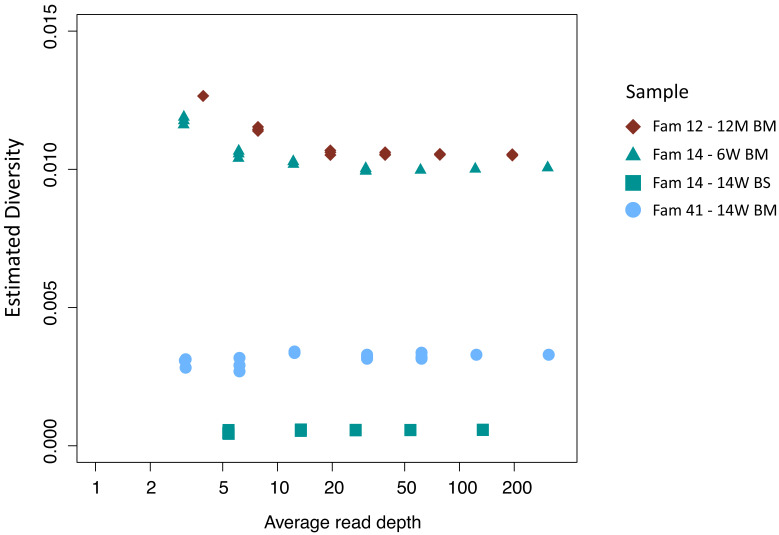
Effect of down-sampling on estimated diversity.Samples tested include family 14: 14W BS (green squares), family 41: 14W BM (blue dots), family 14: 6W BM (green triangles), family 12: 12M BM (maroon diamonds) all of which had initial read depths of 150 or more. The estimated diversity is relatively insensitive to read depth; in particular, down-sampling of high-read-depth samples shows no tendency of the analysis to underestimate the diversity of low-read-depth samples. This indicates that the low diversity observed in many of the CV and BS samples is not an artefact but is rather consistent with the presence of significant bottlenecks.